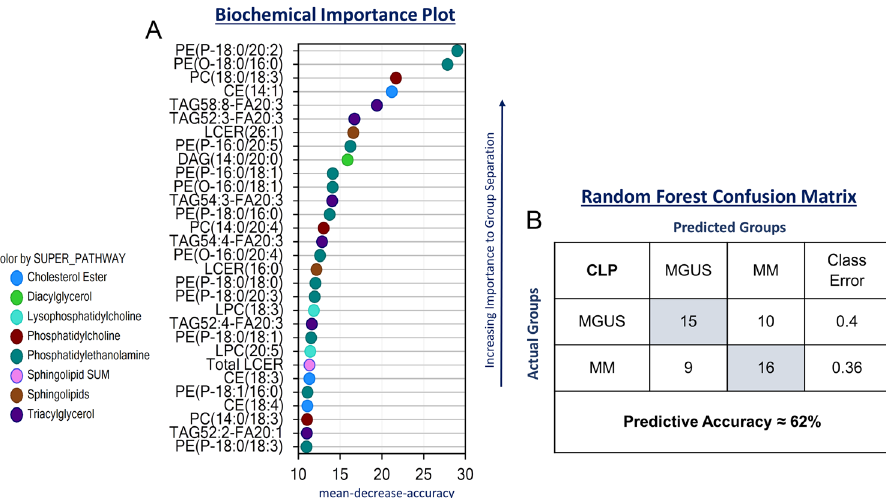
Figure 2. ( A ) Random forest analysis of bone marrow plasma samples from patients with MGUS (N = 25) and MM (N = 25) based on concentrations of complex lipids depicting top 30 complex lipids responsible for group separation between MGUS and MM. ( B ) Random forest confusion matrix demonstrating the performance of the model generated by the random forest analysis of complex lipids in accurately predicting MM and